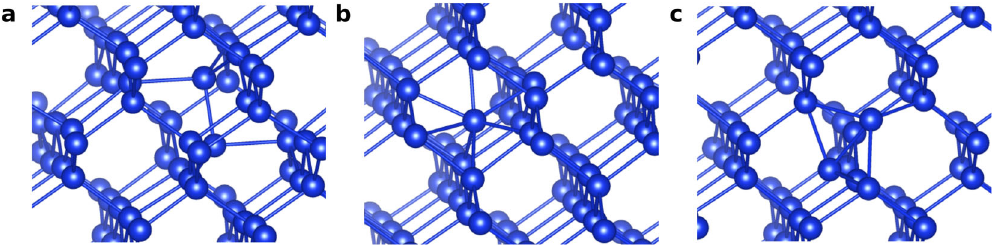
Fig. 6 Defective structures in stoichiometric Si supercells found by the clustering method. a The FFCD. b The Frenkel pair where Si i is in an hexagonal interstice. c The Frenkel pair where the interstitial Si is in the split 〈 110 〉 con fi guration. Images created with VESTA 73